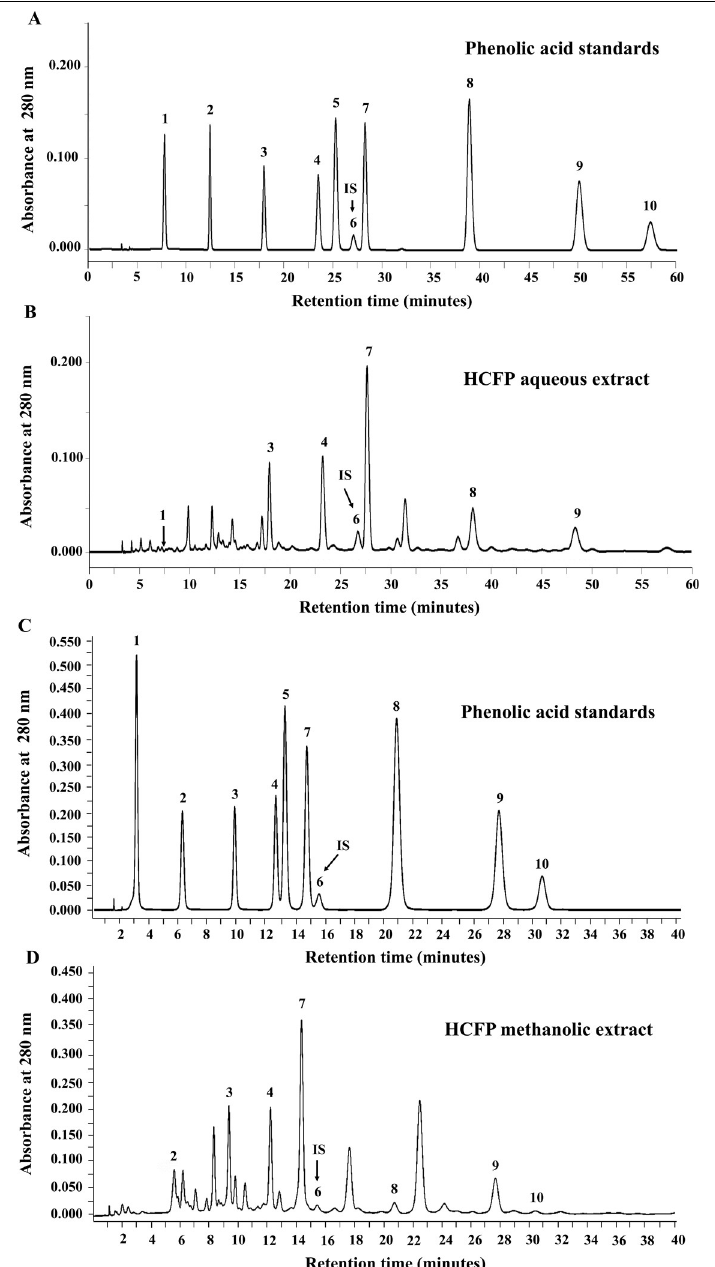
Fig 6. HPLC chromatograms of phenolic acid standards (A, C) and base hydrolyzed HCFP aqueous (B) and methanolic (D) extracts, where 1 = gallic acid, 2 = protocatechuic acid, 3 = p -hydroxybenzoic acid, 4 = vanillic acid, 5 = caffeic acid, 6 = m -hydroxybenzaldehyde, 7 = syringic acid, 8 = p -coumaric acid, 9 = ferulic acid and 10 = sinapinic acid. The m -hydroxybenzaldehyde was used as an internal standard